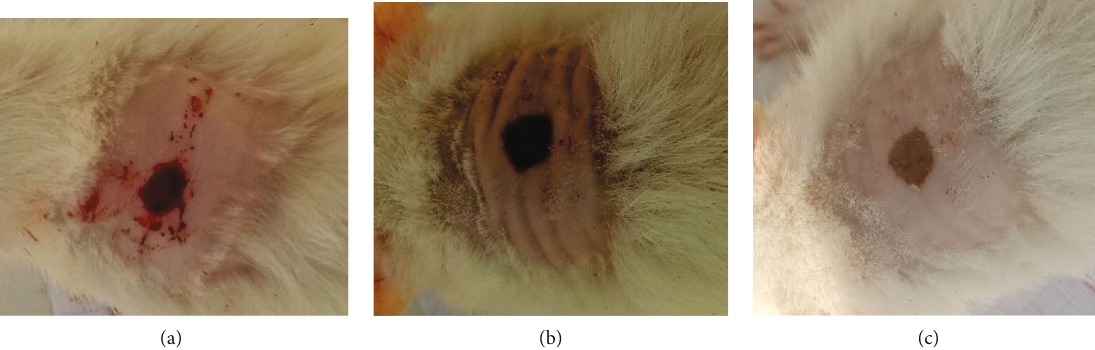
Figure 6: Rat wounds after removal of bandages (24 h): (a) classic gauze dressing (the wound was opened after the animal ’ s motor activity); (b) miramistin-loaded D500-g-PAA-0.4 hydrogel; (c) cefuroxime-loaded D500-g-PAA-0.4